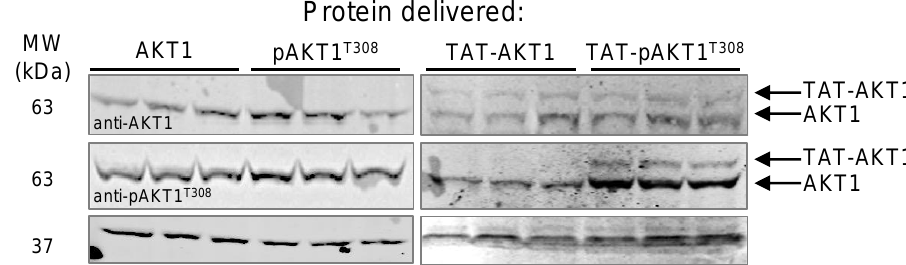
Figure 3. Delivery of TAT-AKT1 protein variants to HEK 293T cells. HEK 293T cells were incubated with AKT1, pAKT1 T308 , TAT-AKT1, or TAT-pAKT1 T308 for 1 h in three biological replicates. Cell extracts were separated by SDS-PAGE and immunoblotted with AKT1, pAKT T308 , and GAPDH specific antibodies. Cells incubated with AKT1 or pAKT1 T308 showed a single band in all blots corresponding to endogenous AKT1. Two bands, corresponding to endogenous AKT1 and TAT-AKT1 separated by size, were apparent in cells transfected with TAT-tagged AKT1 variants, demonstrating effective delivery of both TAT-tagged AKT1 variants into cells. TAT-AKT1 delivery did not lead to phosphorylation of TAT-AKT1 in cells, as no phosphorylated TAT-AKT1 was detected by the pThr308 specific antibody after 1 h. The delivered TAT-pAKT1 T308 was readily detected by phospho-specific antibody for pAKT T308 .